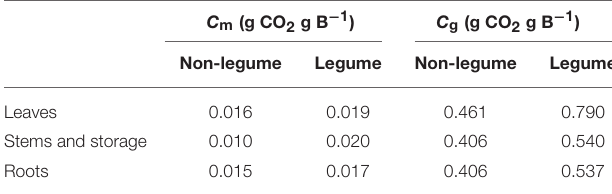
TABLE 3 | Organic matter (%) at different depths used for initial conditions at each site (adapted from Purakayastha et al., 2008).